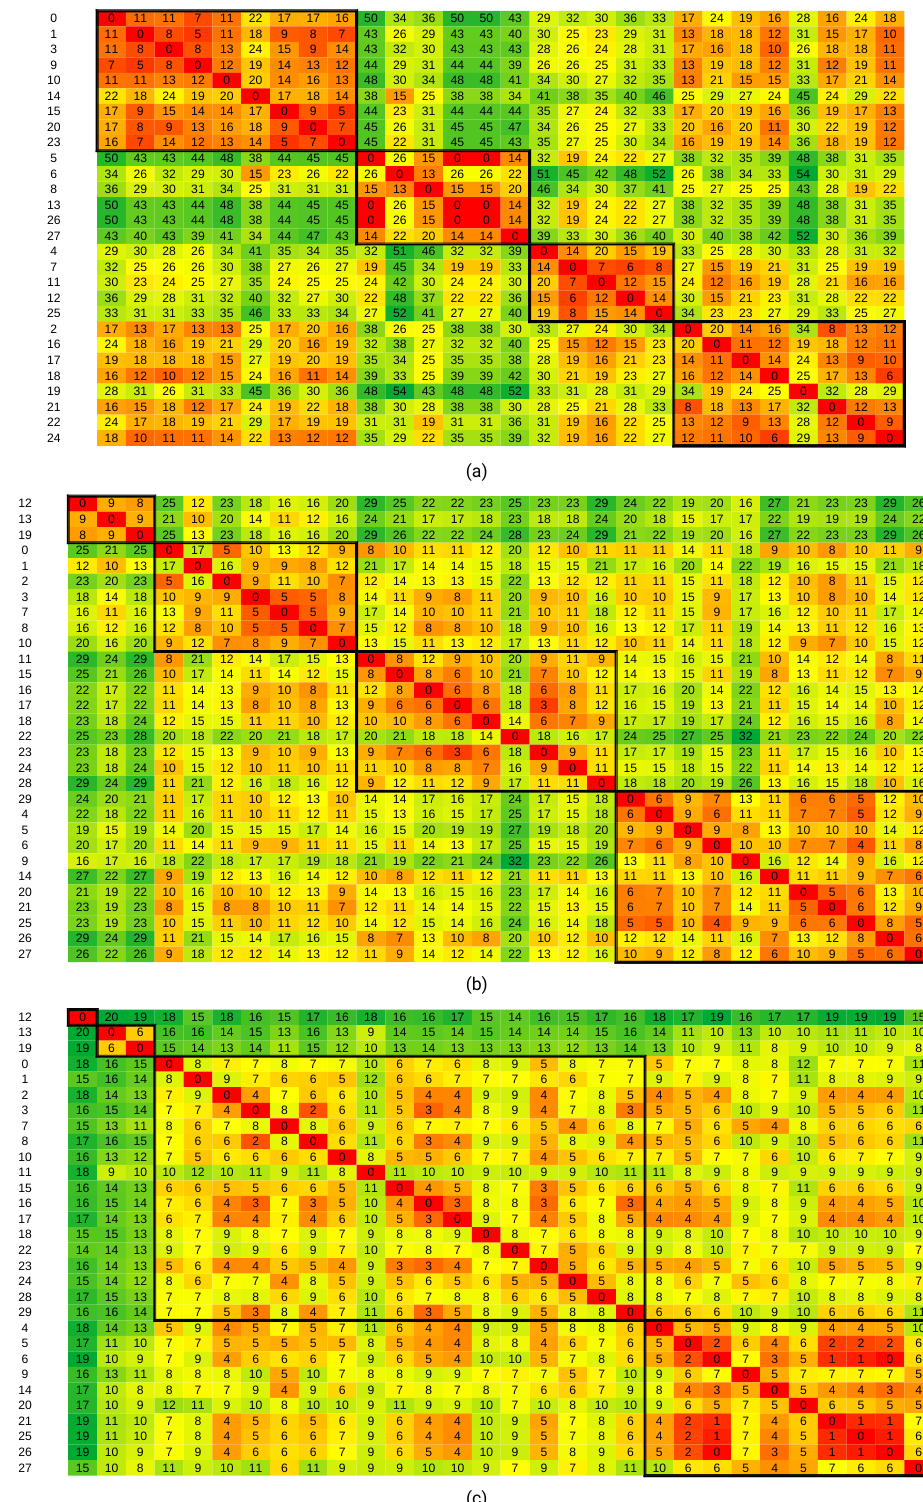
Figure 6. Distance matrices of the H3 metric between daily activity vectors for ( a ) Kasteren dataset, ( b ) The first resident of the CASAS 11 dataset, and ( c ) The second resident of the CASAS dataset. Values are in thousands. The background color shows gradient changes in values, with red tones indicating low values and green tones indicating high